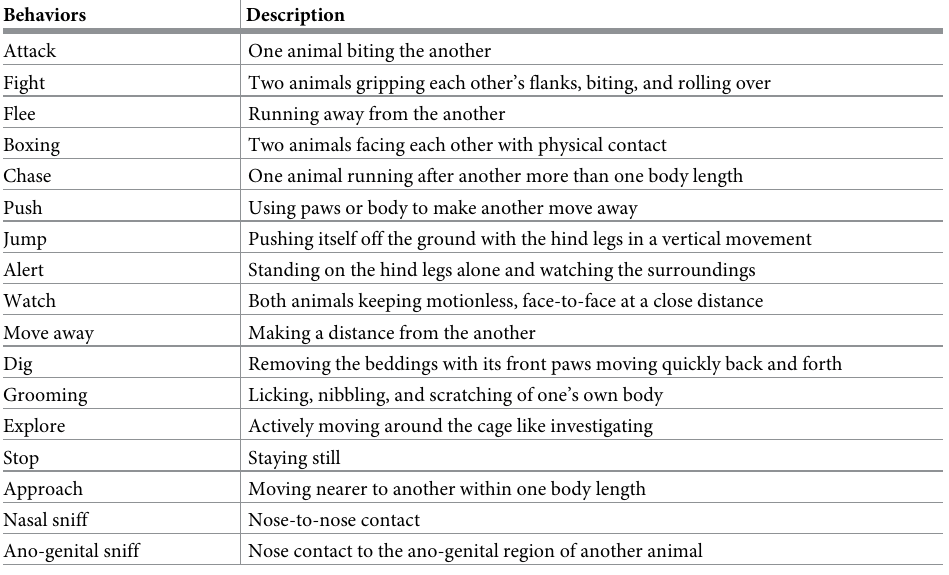
Table 1. Descriptions of behaviors that were